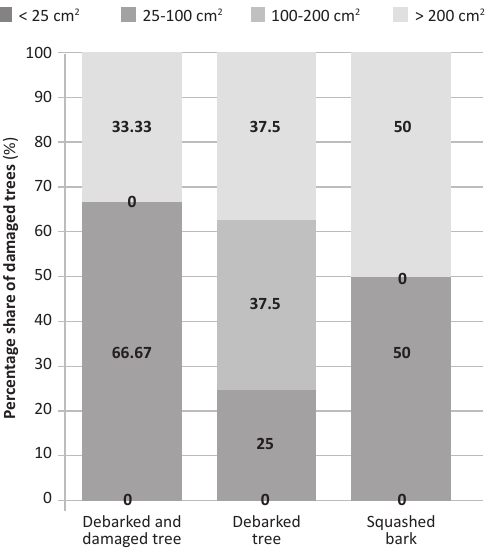
FIgURe 8. The distribution of different size damages depen- ding on the damage position.